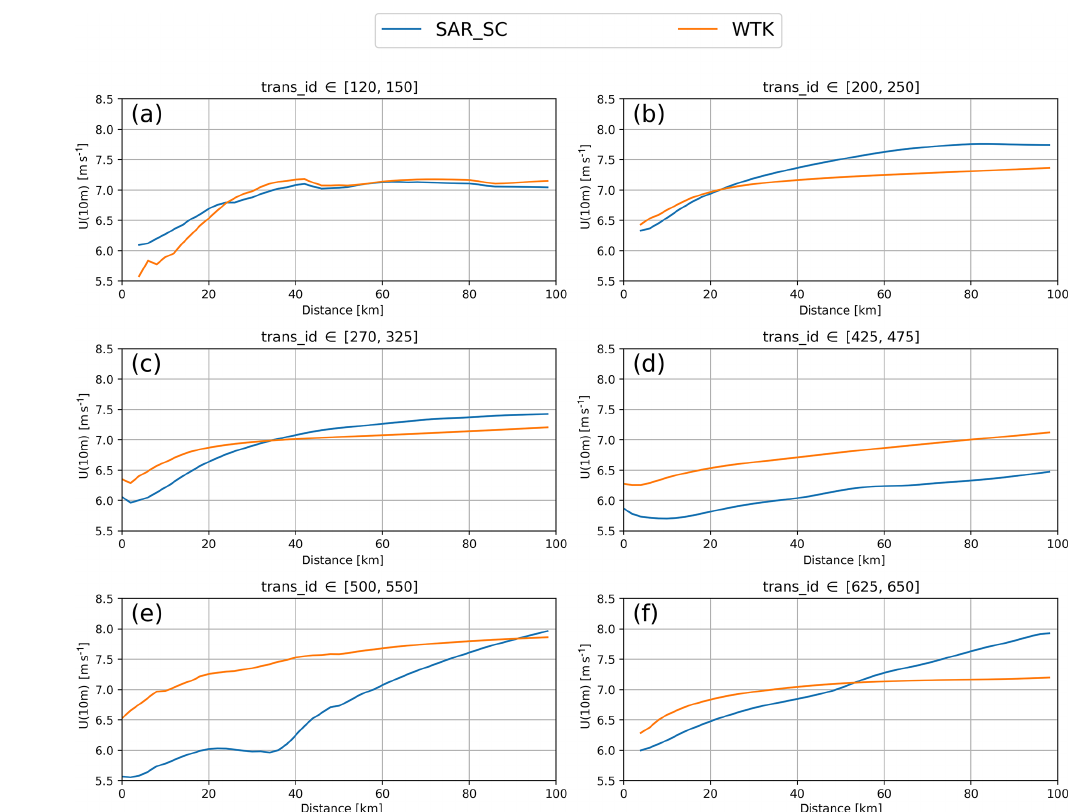
Figure 12. Mean wind speeds averaged over several transects covering six different regions. The panels are as follows from north to south: (a) Nantucket, (b) Long Island, (c) state of New York, (d) Virginia to Delaware, (e) Pamlico Sound, (f) southern part of North